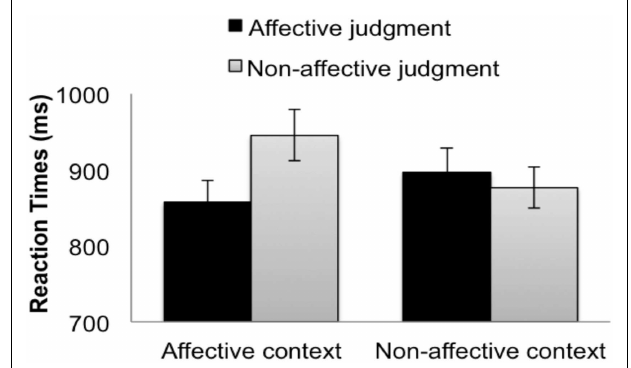
FIGURE 5 | Reaction times for the combined (picture and word) targets from Experiments 1 and 2 when participants made affective judgments (dark bars) and non-affective judgments (light bars) in the affective context group (left bars) and the non-affective context group (right bars). The error bars indicate subject-wise SEM.